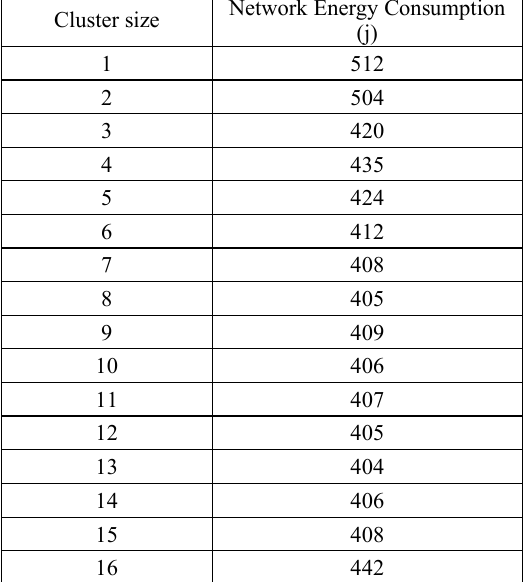
Table 5. Network Energy Consumption Vs. Cluster